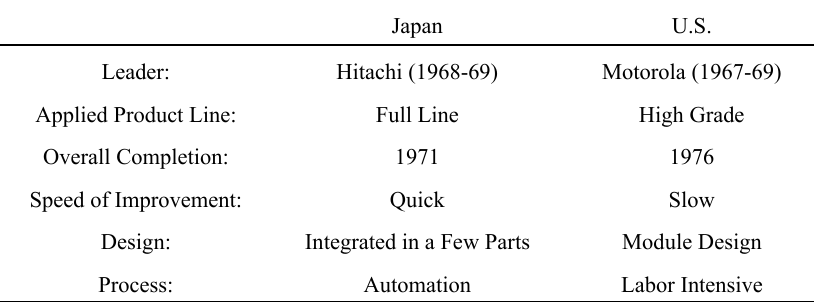
Table 3. Comparison of Response in U.S. and